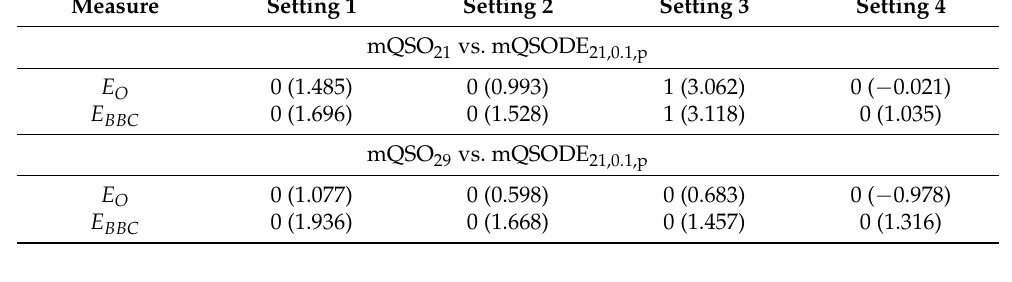
Figure 2. Current error graphs of mQSO 29 and mQSODE 21,0.1,p in four benchmark settings.